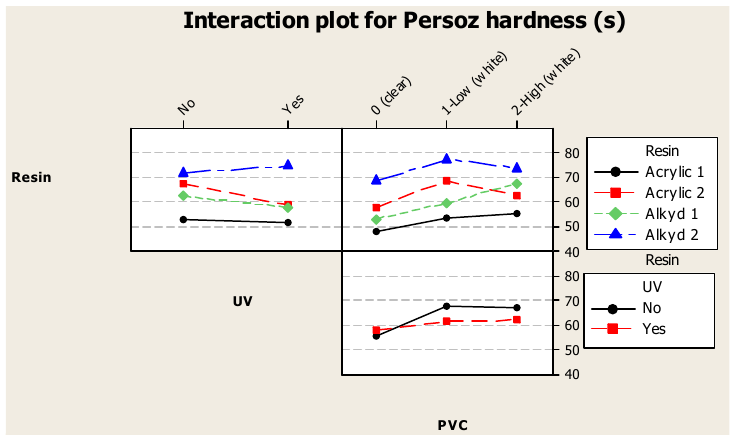
Figure 2. Interaction plot for the mean Persoz hardness.